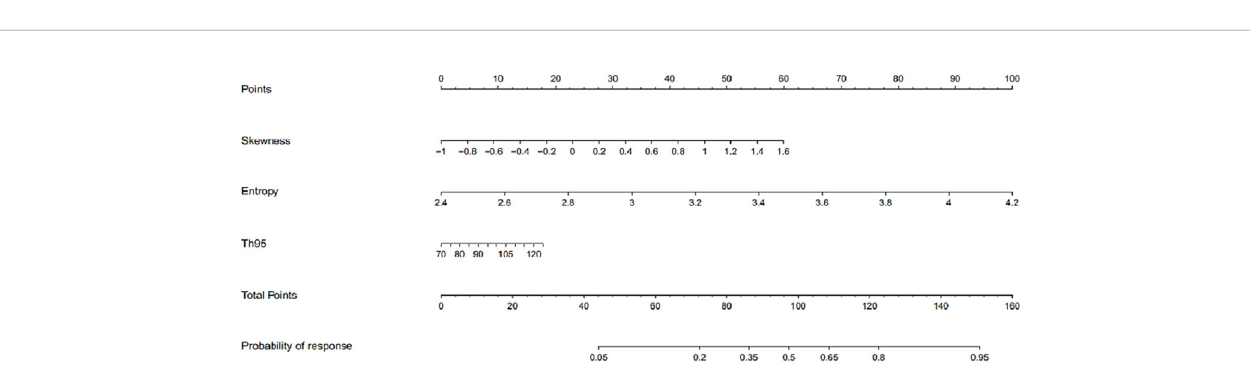
FIGURE 4 | The developed nomogram for prediction of ef fi cacy of intravenous methylprednisolone pulse (ivMP) therapy for thyroid-associated ophthalmopathy (TAO), incorporating the 95th percentile T2 relaxation time (T2RT), skewness, and entropy. In this nomogram, entropy is the greatest predictor of therapeutic response (100 points), followed by skewness (60 points), and 95 th percentile T2RT (18 points).